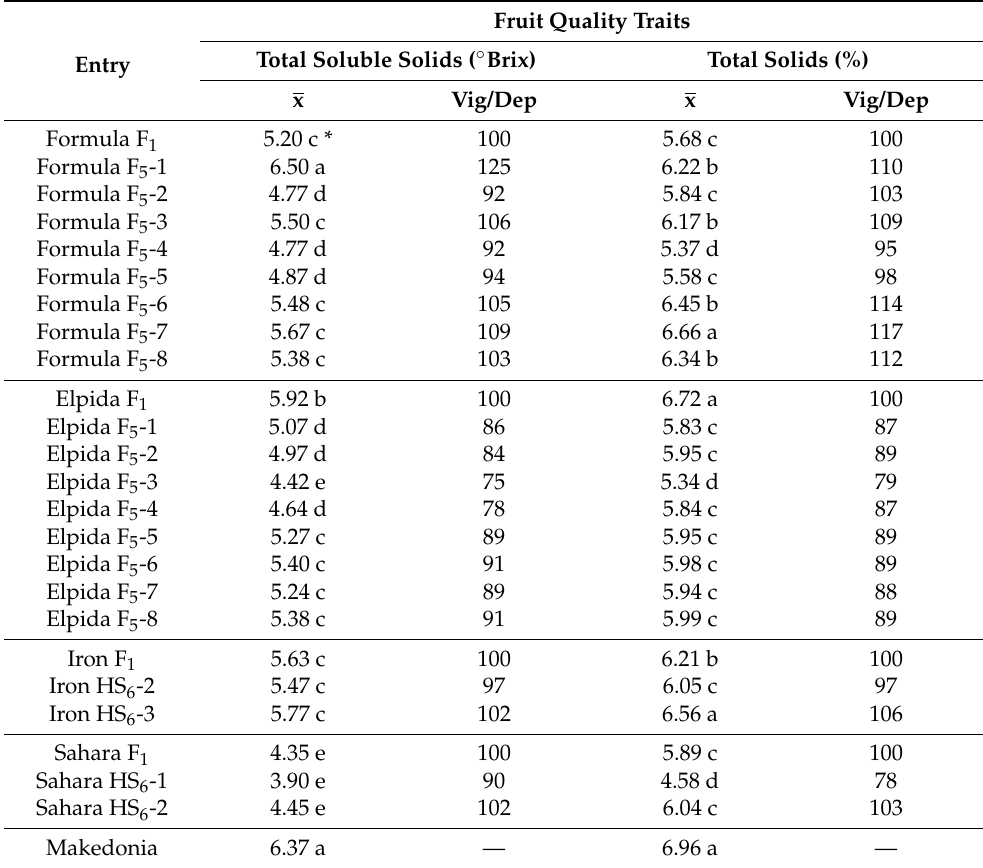
Table 5. Fruit quality traits: total soluble solids ( ◦ Brix), total solids (%), and vigor or depression (% of its corresponding hybrid) of F 1 hybrids and their recombinant lines.